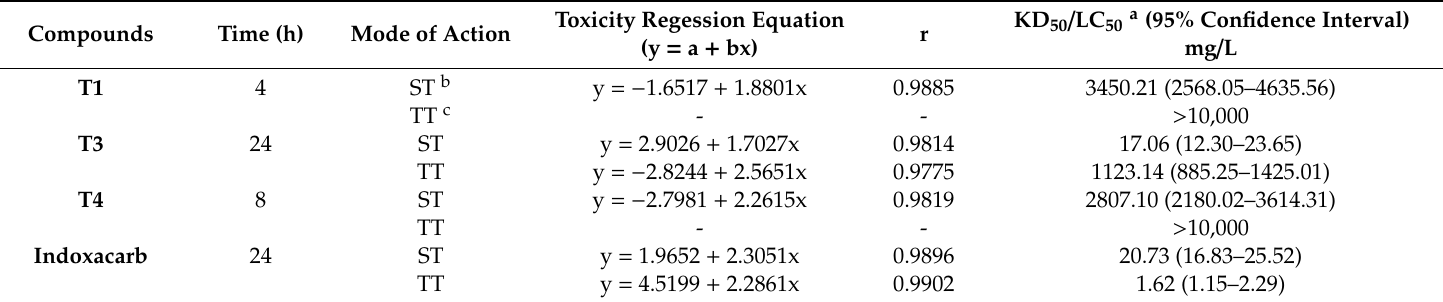
Table 3. Insecticidal activity of compounds against M.